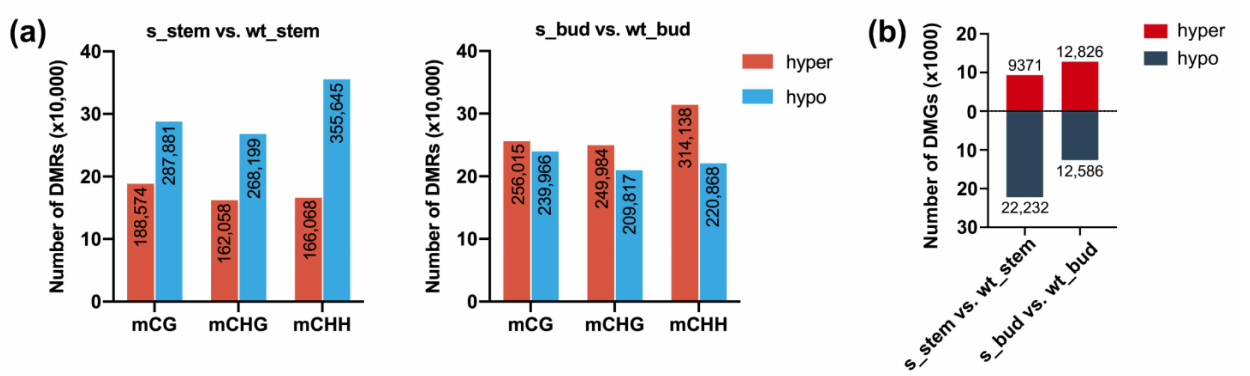
Figure 3. DMRs (differentially methylated regions) analysis of the stem and bud from wild-type and BrCHR39 -silenced plants. ( a ) The number of DMRs in s_stem vs. wt_stem and s_bud vs. wt_bud. ( b ) The number of DMGs (DMR-related genes) in s_stem vs. wt_stem and s_bud vs. wt_bud. Hyper, hypermethylated. Hypo,